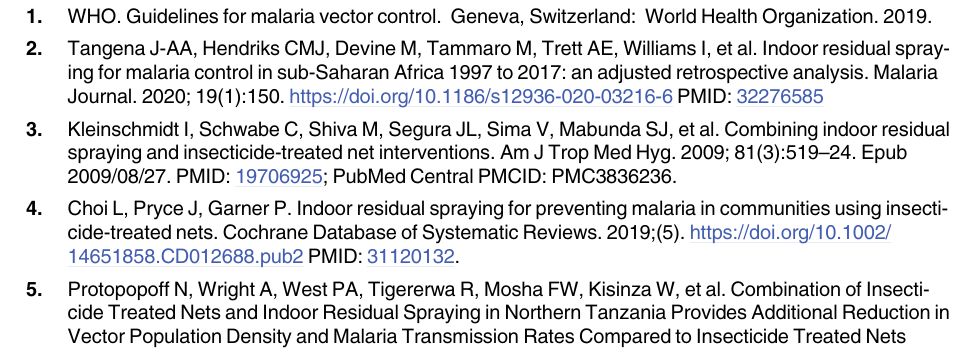
S2 Table. Detailed in situ cone bioassays data with susceptible An gambiae Kisumu in experimental